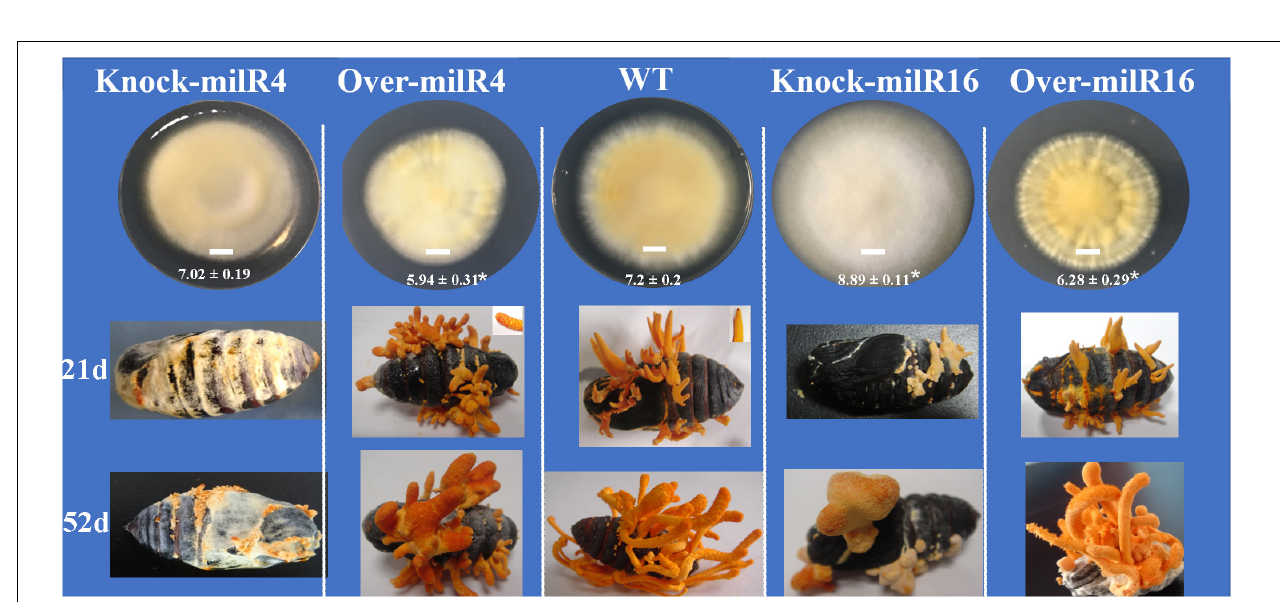
FIGURE 4 | Asexual and sexual development of the wild type and different mutant strains. Bar = 1 cm. The diameters of different strains are showed under the Bar. The asterisk “ ∗ ” represents a significant difference level of P < 0.05 compared to WT.